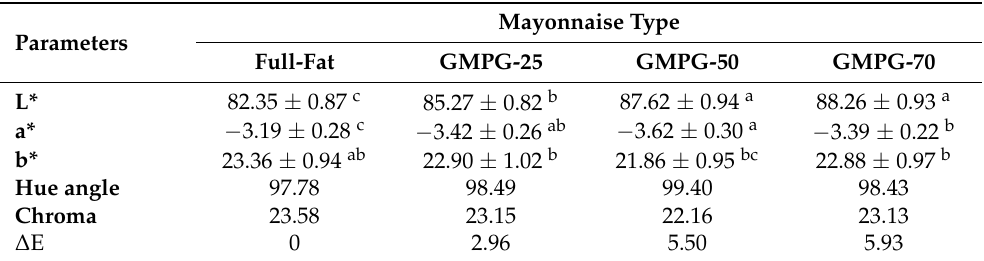
Table 5. Color parameters (L*, a*, and b*) of full-fat mayonnaises and mayonnaise with replacement of oil by Gurma melon pulp gel (GMPG).